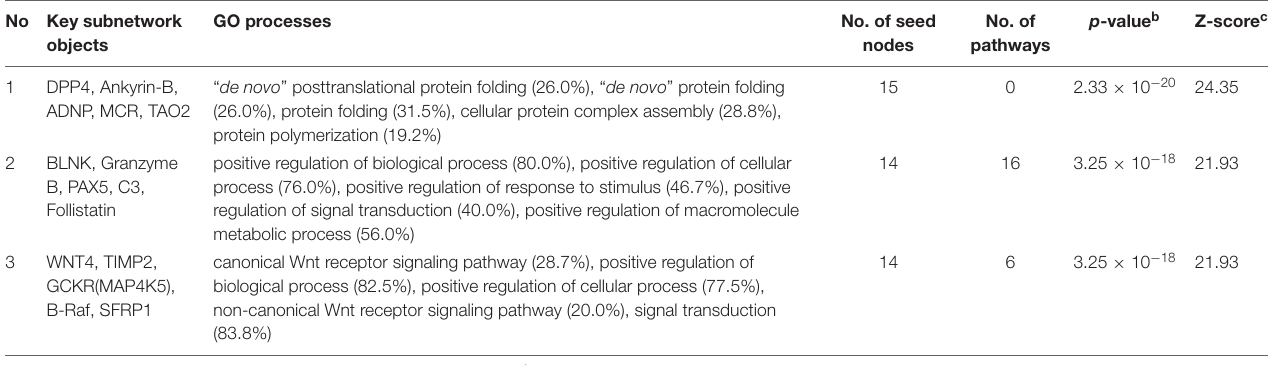
TABLE 3 | The top three biologically enriched subnetworks a